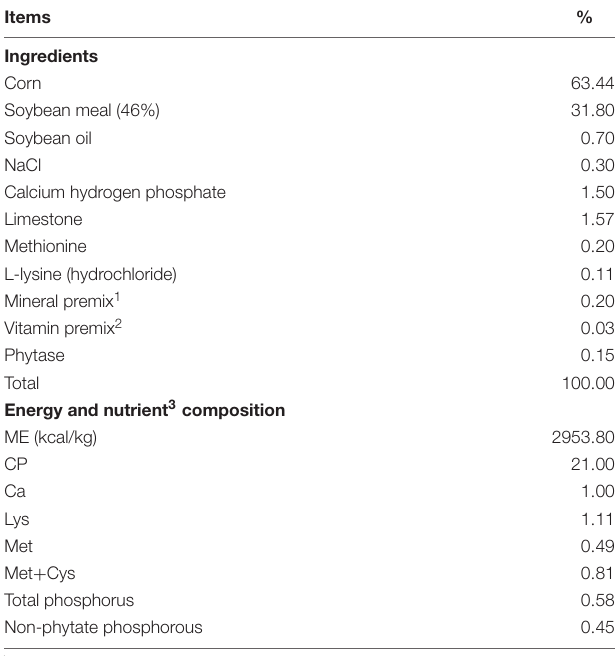
TABLE 1 | Diet composition and nutrient levels during the experiment (dry basis).